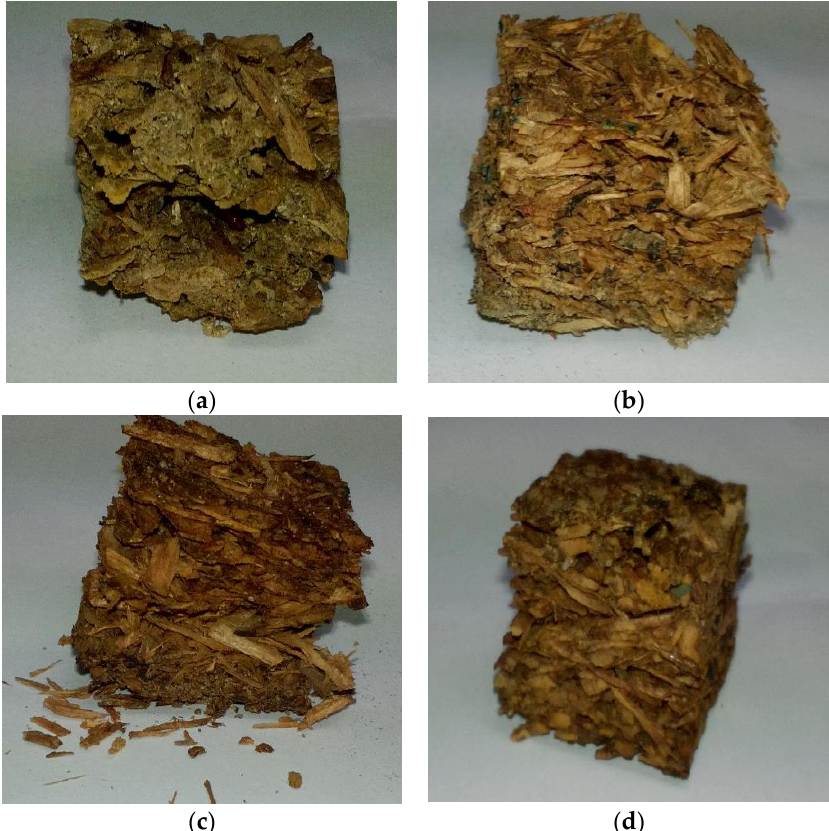
Figure 5. Visual appearance of particleboard (25 mm × 25 mm) after 4-week exposure to Coptotermus curvignathus : ( a ) control, ( b ) 10 wt% citric acid, ( c ) 15 wt% citric acid * and ( d ) 20 wt% citric acid. * Zhou et al. [17].